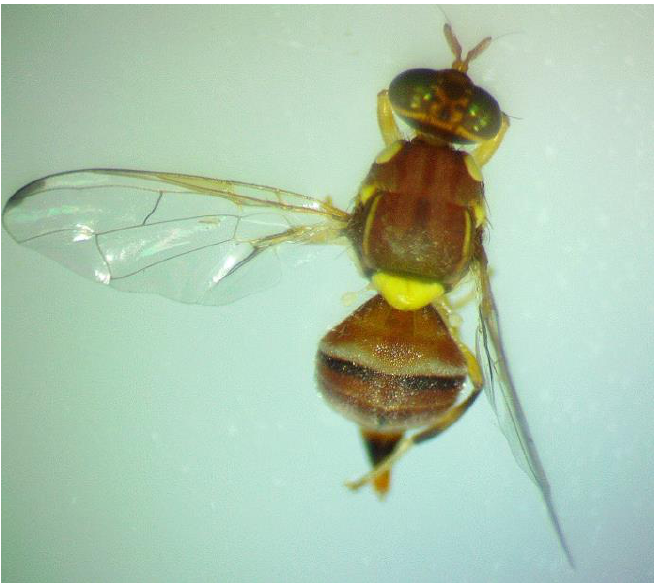
Figure 2. Dorsal and wing view of adult peach fruit fly, B. zonata (Saunders), sampled from olive at Giza-1 site.